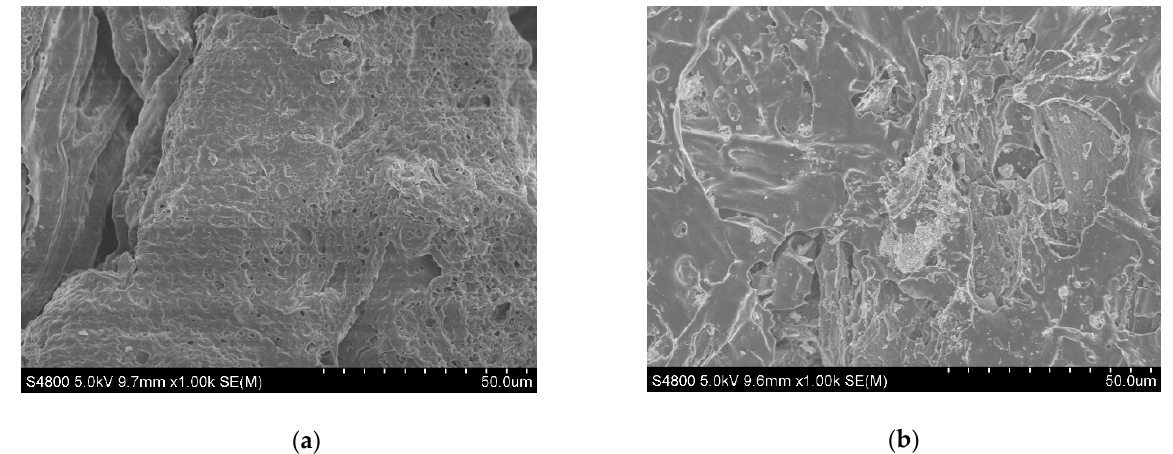
Figure 3. The scanning electron microscopy (SEM) images of ( a ) PCB and ( b ) HB.